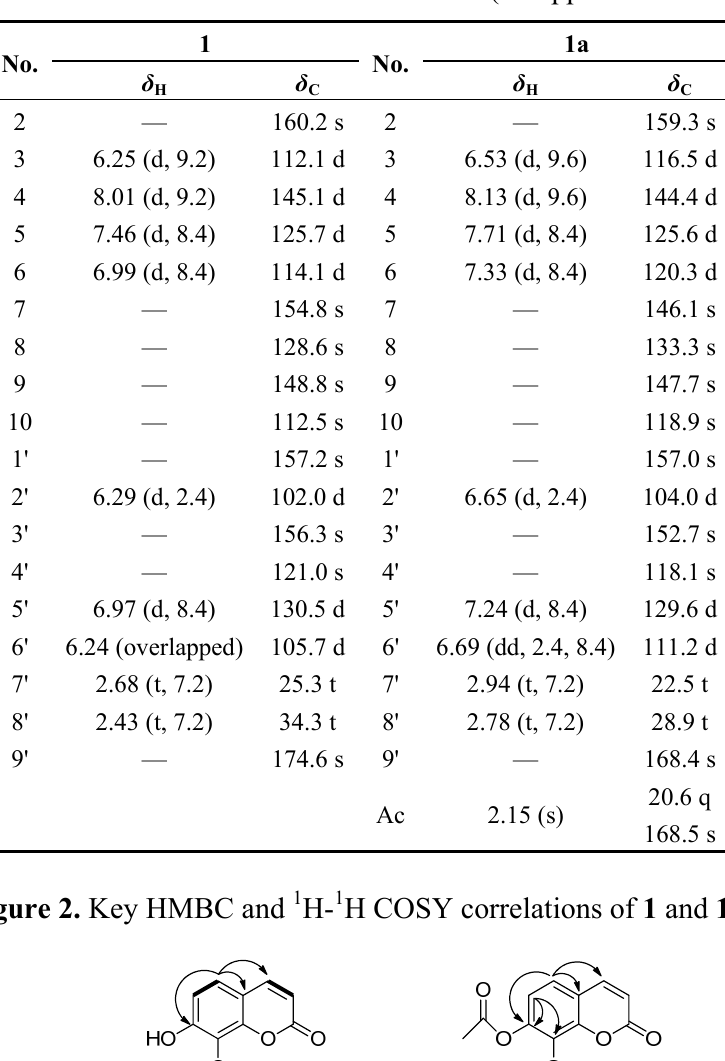
Table 1. 1 H- and 13 C-NMR data of 1 and 1a ( δ in ppm and J in Hz).